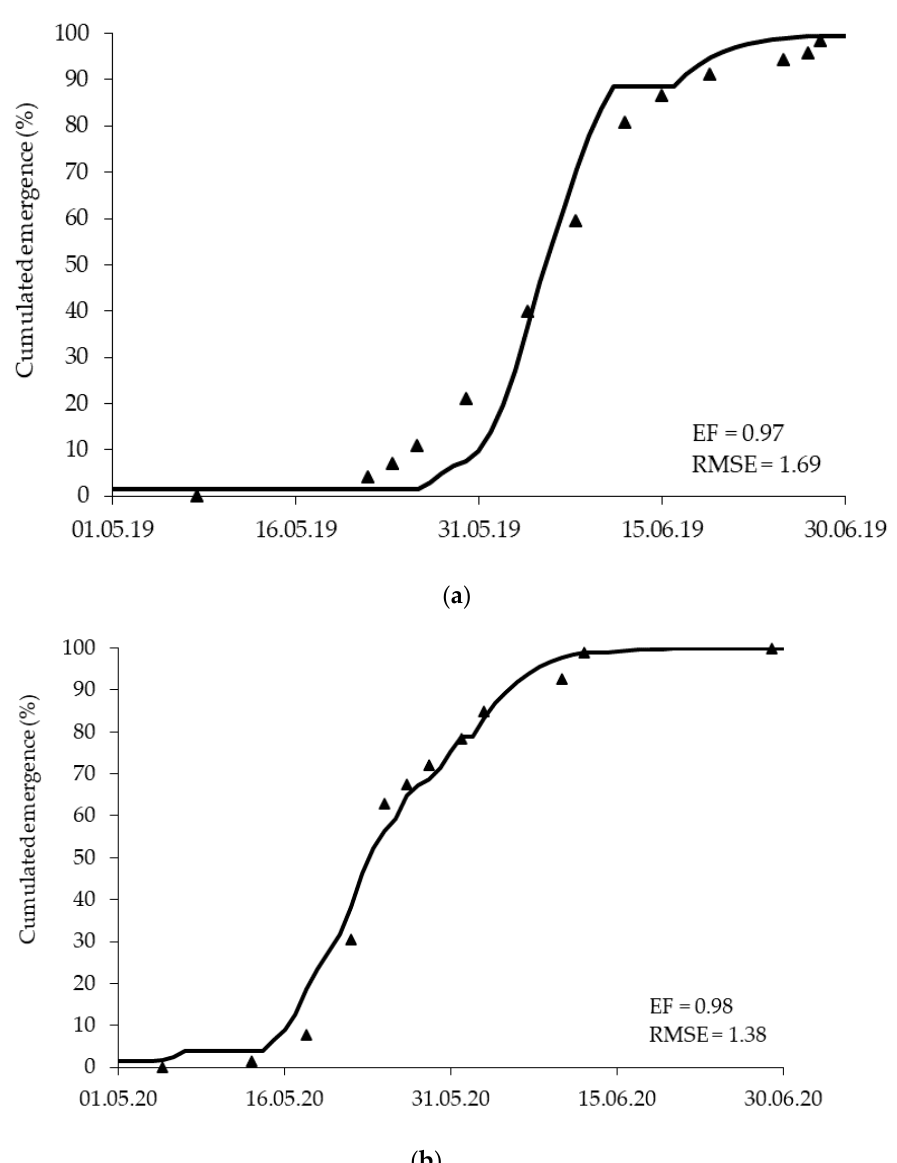
Figure 4. Cumulative emergence of Echinochloa crus-galli observed in the field (triangle) during 2019 ( a ) and 2020 ( b ) and the AlertInf prediction of emergence (line). Hydrothermal units are expressed